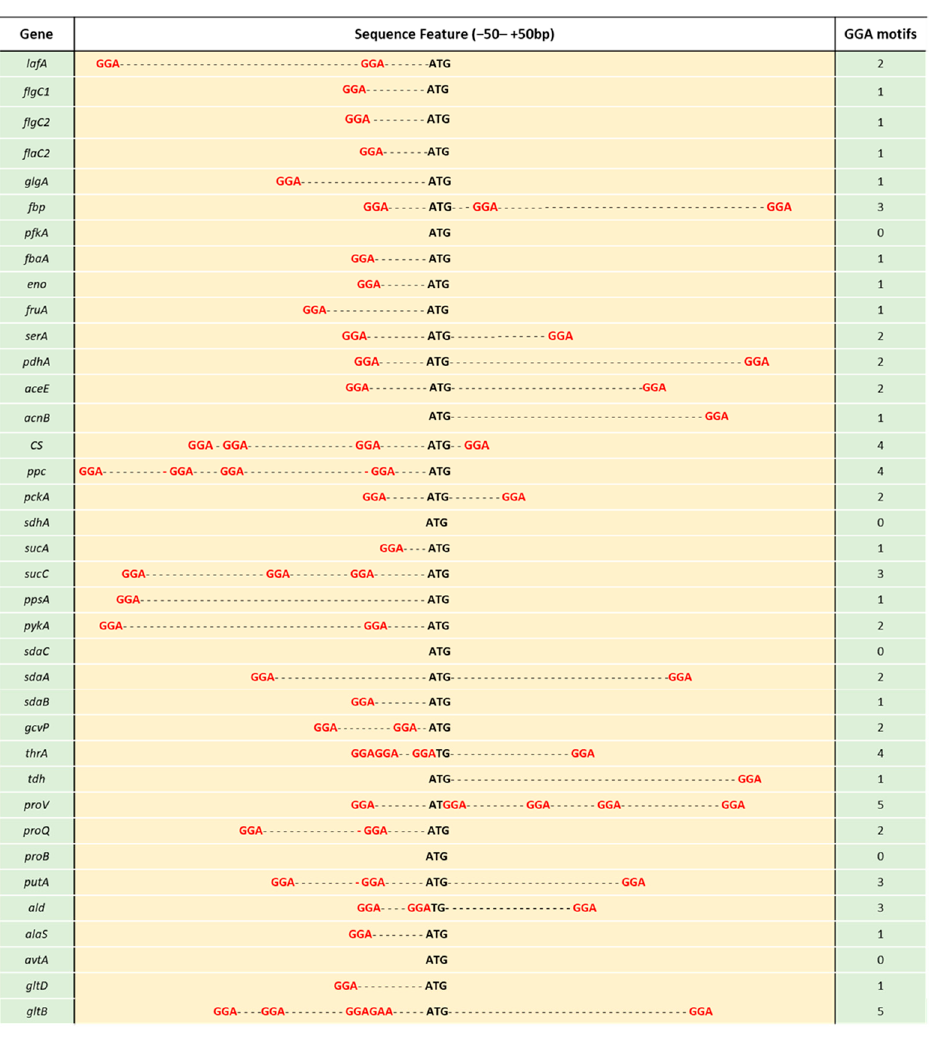
Figure 9. GGA motifs of sequences ranging from − 50 to +50 bp of the initiation codon. Bold letters (depicted in black) indicate the start codon and bold letters (depicted in red) indicate GGA motifs. A short horizontal line represents the base of a gene.